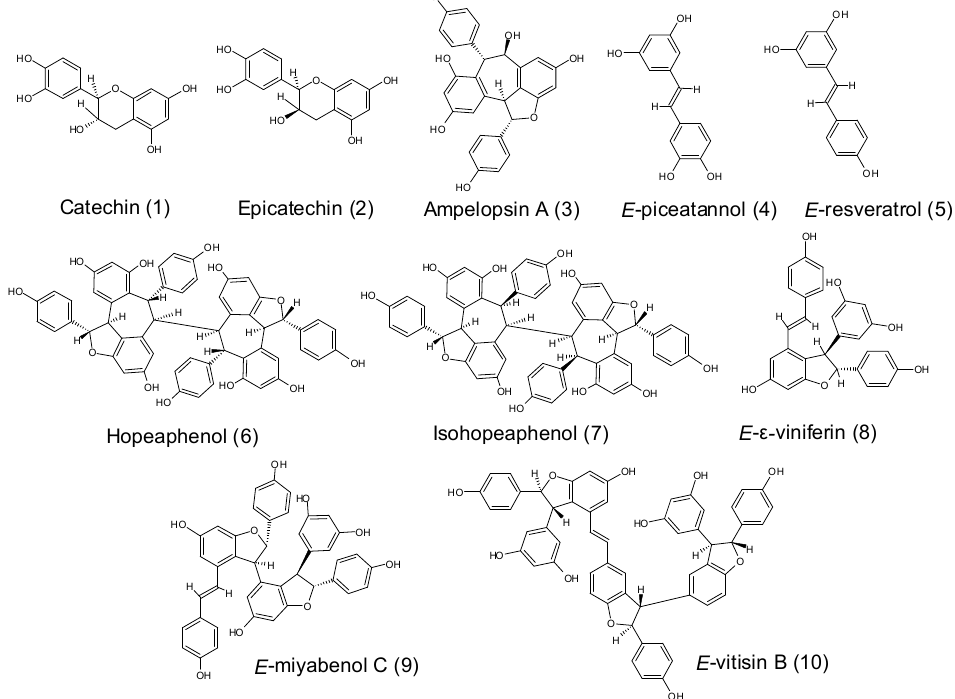
Figure 1. The structures of major polyphenols analyzed in